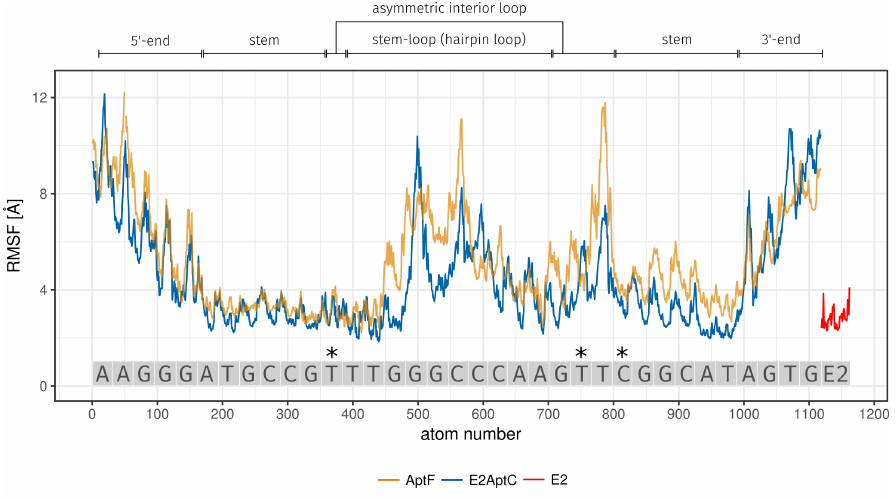
Figure 4. RMSF of aptamer and E2 atoms during 25 ns MD simulation. RMSF comparison between AptF (orange line) and E2AptC (blue line). E2 is a part of E2AptC MD simulation and is depicted as a red line. The various secondary structures of the E2-specific aptamer are shown above the plot and the binding bases of E2 are highlighted with the asterisk symbol ( ∗ ). AptF, aptamer-free; E2, 17 β -estradiol;